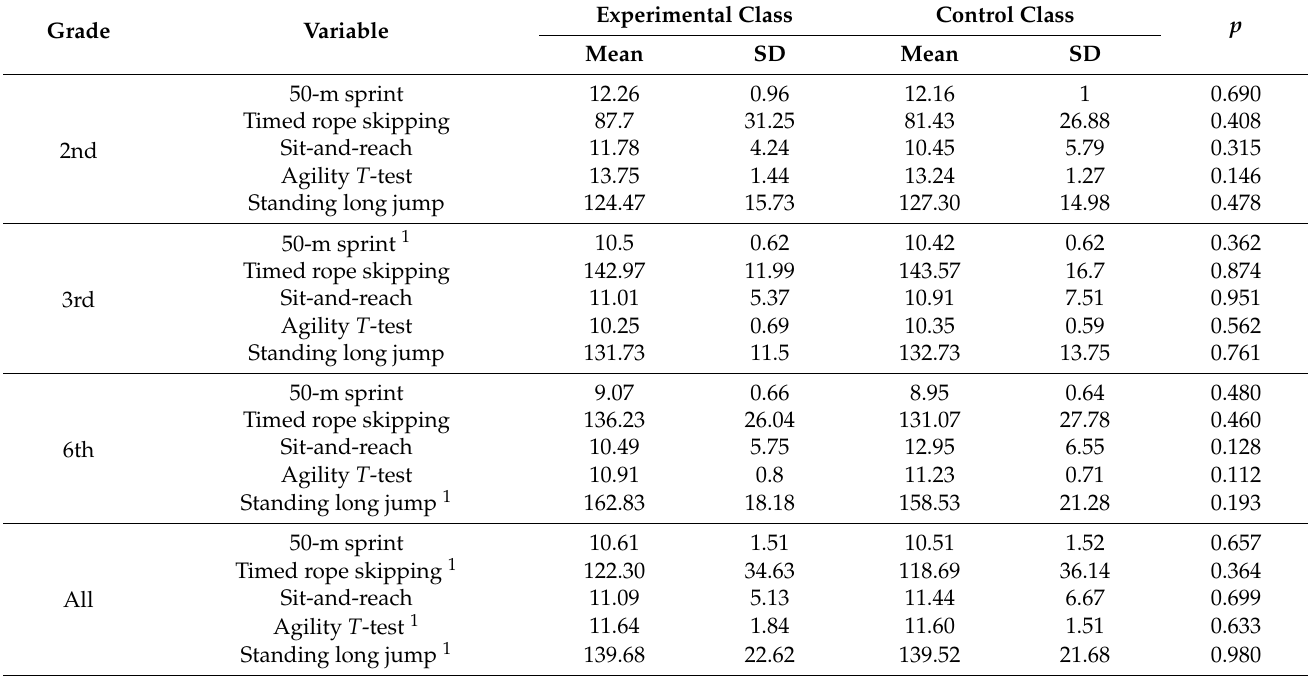
Table 3. Students’ PF characteristics during the baseline